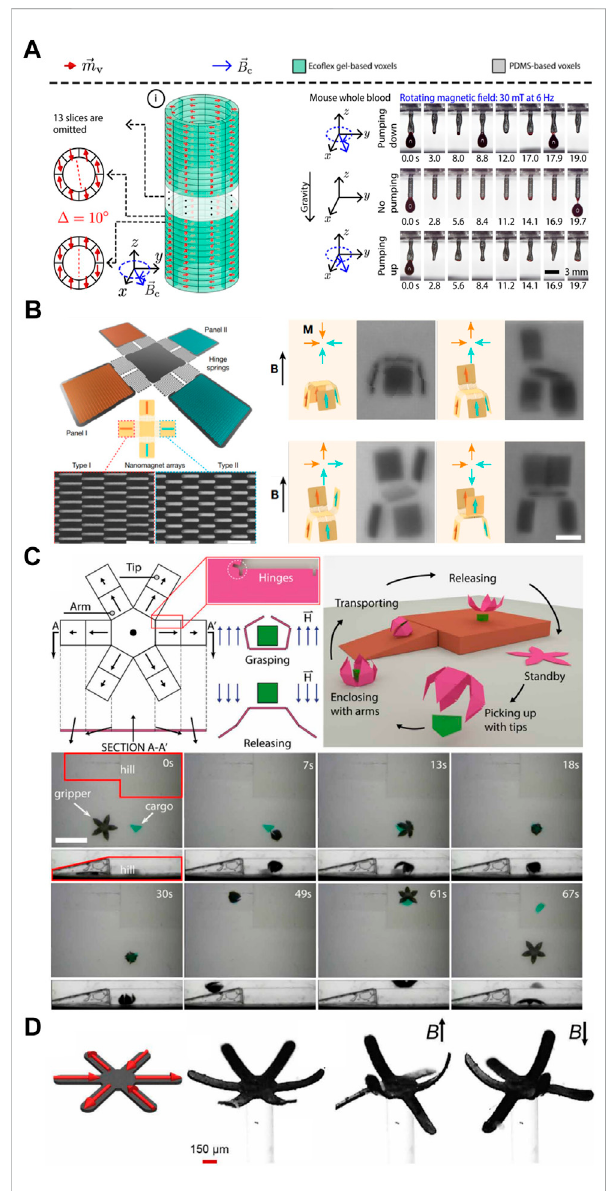
FIGURE 2 Examples of programmable voxel-based magnetic soft robots, demonstrating their structure and actuation (A) Magnetic microtubular soft robot observing wireless peristaltic actuation to pump micro fl uidic volumes of mouse blood from an attached reservoir(scalebar,3 mm);from(Zhang J.etal.,2021),reprintedwith permissionfromAAAS (B) Origami-inspiredmagneticmicromachine, observing multiple folded panel con fi gurations for proposed nanonewton-scale cell manipulation (scale bars, 500 nm for the magni fi ed nanomagnetic array image, and 10 µm for the shape con fi gurationimages);from(Cuietal.,2019),reprintedbypermission from(Cuietal.,2019);Copyright © 2019SpringerNature (C)